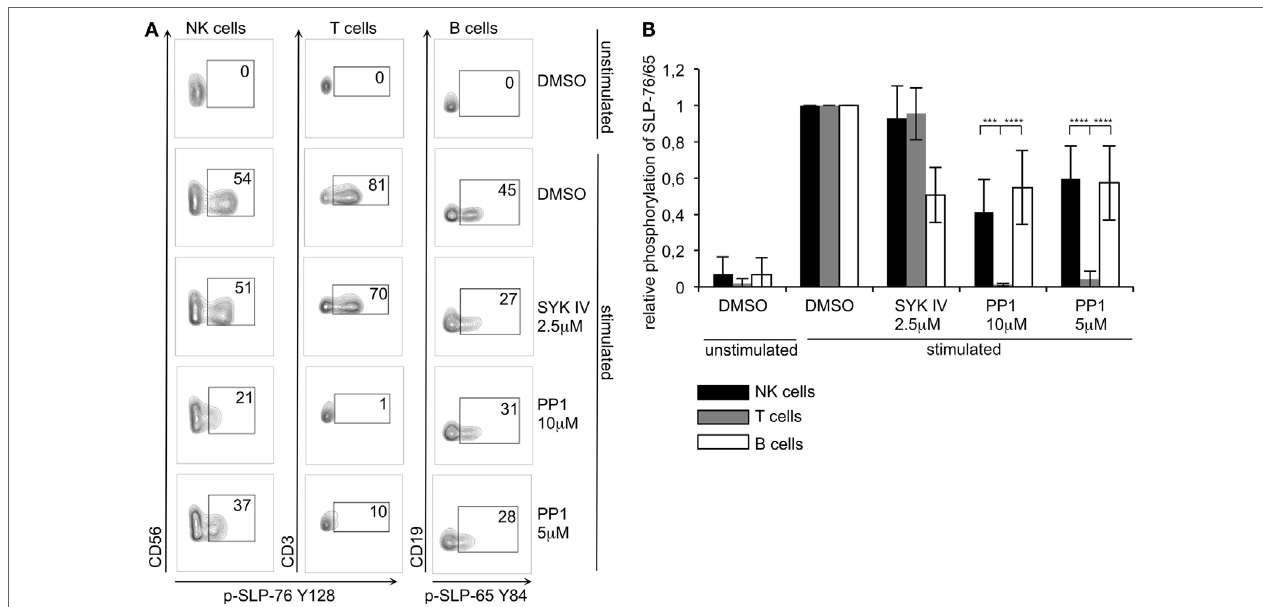
FigUre 6 | ZAP70 expressing human T cells are more sensitive to inhibition of Src-family kinases than SYK/ZAP70 expressing natural killer (NK) cells or SYK- expressing B cells (a) Human peripheral blood mononuclear cells were preincubated in the presence of the indicated inhibitors or DMSO control with mAbs specific for CD16 (to stimulate NK cells), CD3 and CD28 (to stimulate T cells), IgM (to stimulate B cells), or an isotype control (unstimulated) for 30 min on ice, followed by cross-linking with secondary goat F(ab ′ ) 2 anti-mouse IgG at 37°C for 2 min. Phosphorylation of SLP-76 in NK (CD3 − CD56 + ) and T (CD3 + CD56 − ) cells or of SLP-65 in B (CD3 − CD19 + ) cells was analyzed by flow cytometry using phosphorylation specific antibodies. (B) Quantification of (A). Normalized data were subjected to two-way ANOVA to discern significant differences ( α = 0,05). Statistical analysis was carried out by using PRISM software ( N = 5 for NK and T cells; N = 3 for B cells). P -values: *** < 0.001; **** <